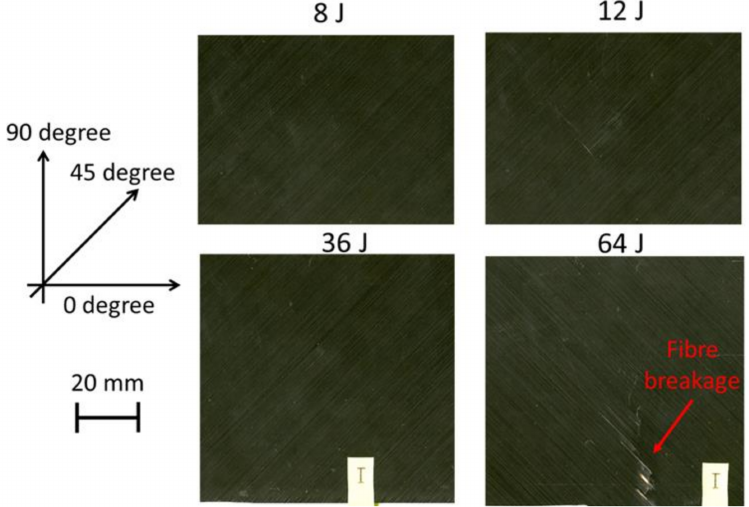
Figure 9. Images of samples that taken from the back face at different impact energy levels using EPSON scanner.